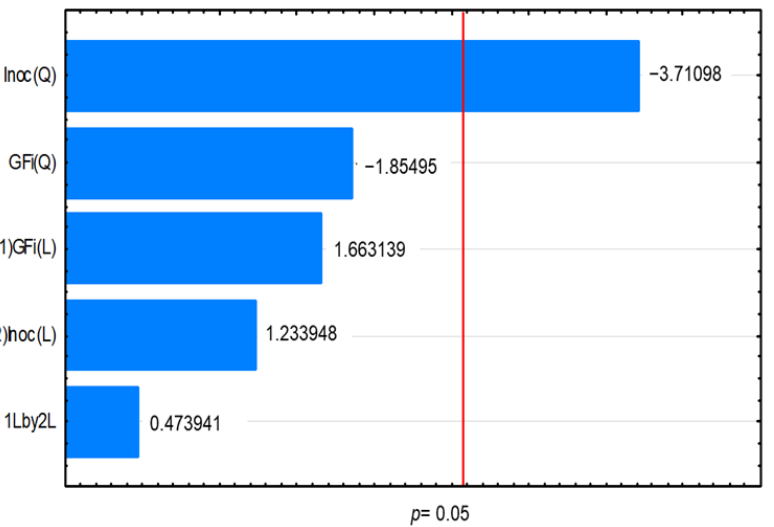
Figure 1. Pareto chart of the standardized effects of the variables initial sucrose (GFi) and inoculum concentration (Inoc) on the fructooligosaccharides production yield.